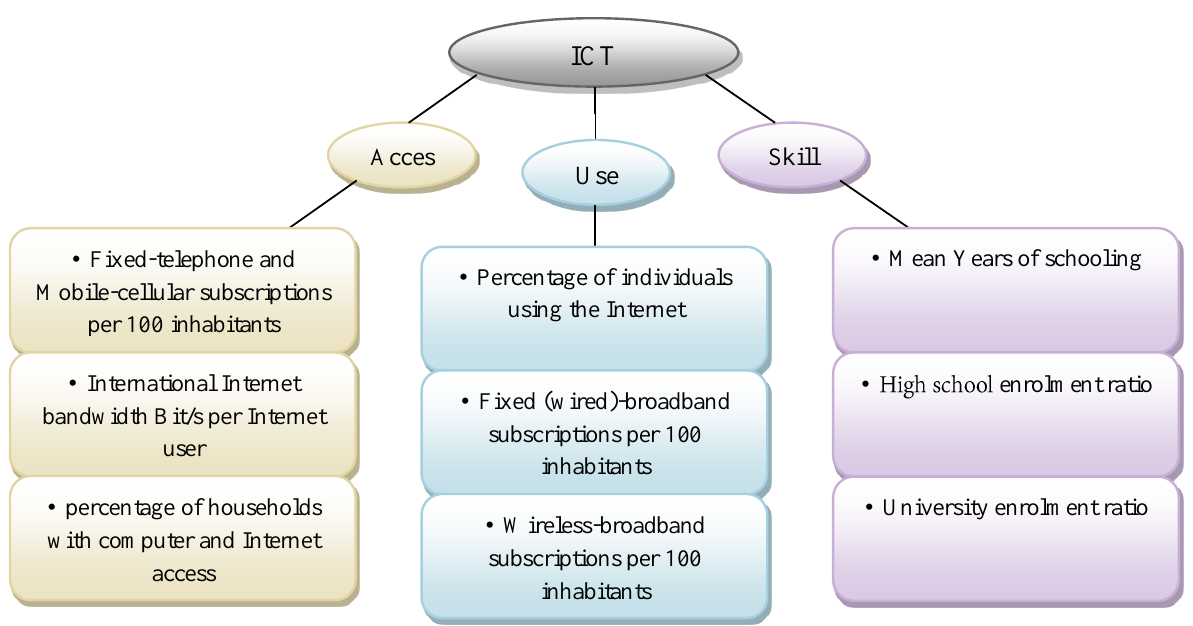
Figure 2. Sub-indices of ICT development